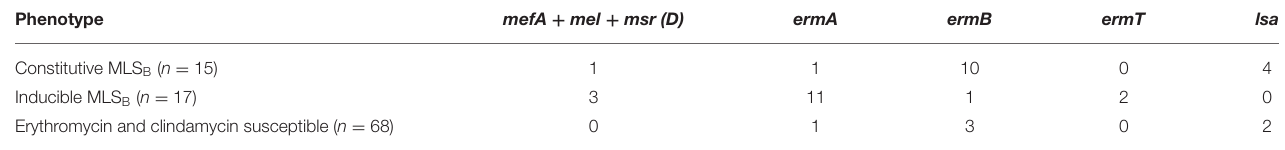
TABLE 7 | Comparison of presence of macrolide resistance genes to phenotypic susceptibility testing for sequenced isolates ( n = 100).